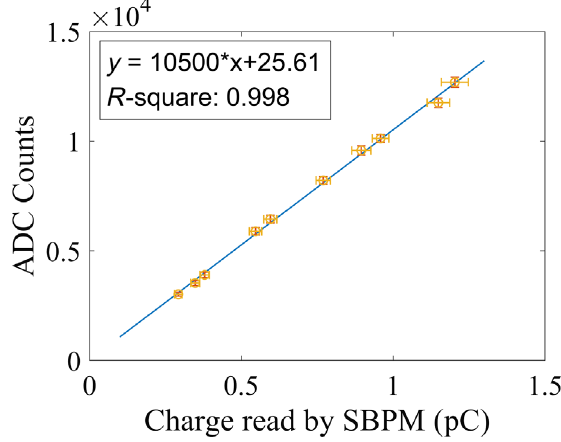
FIG. 13. ADC counts of the BAM vs charge read by the SBPM.